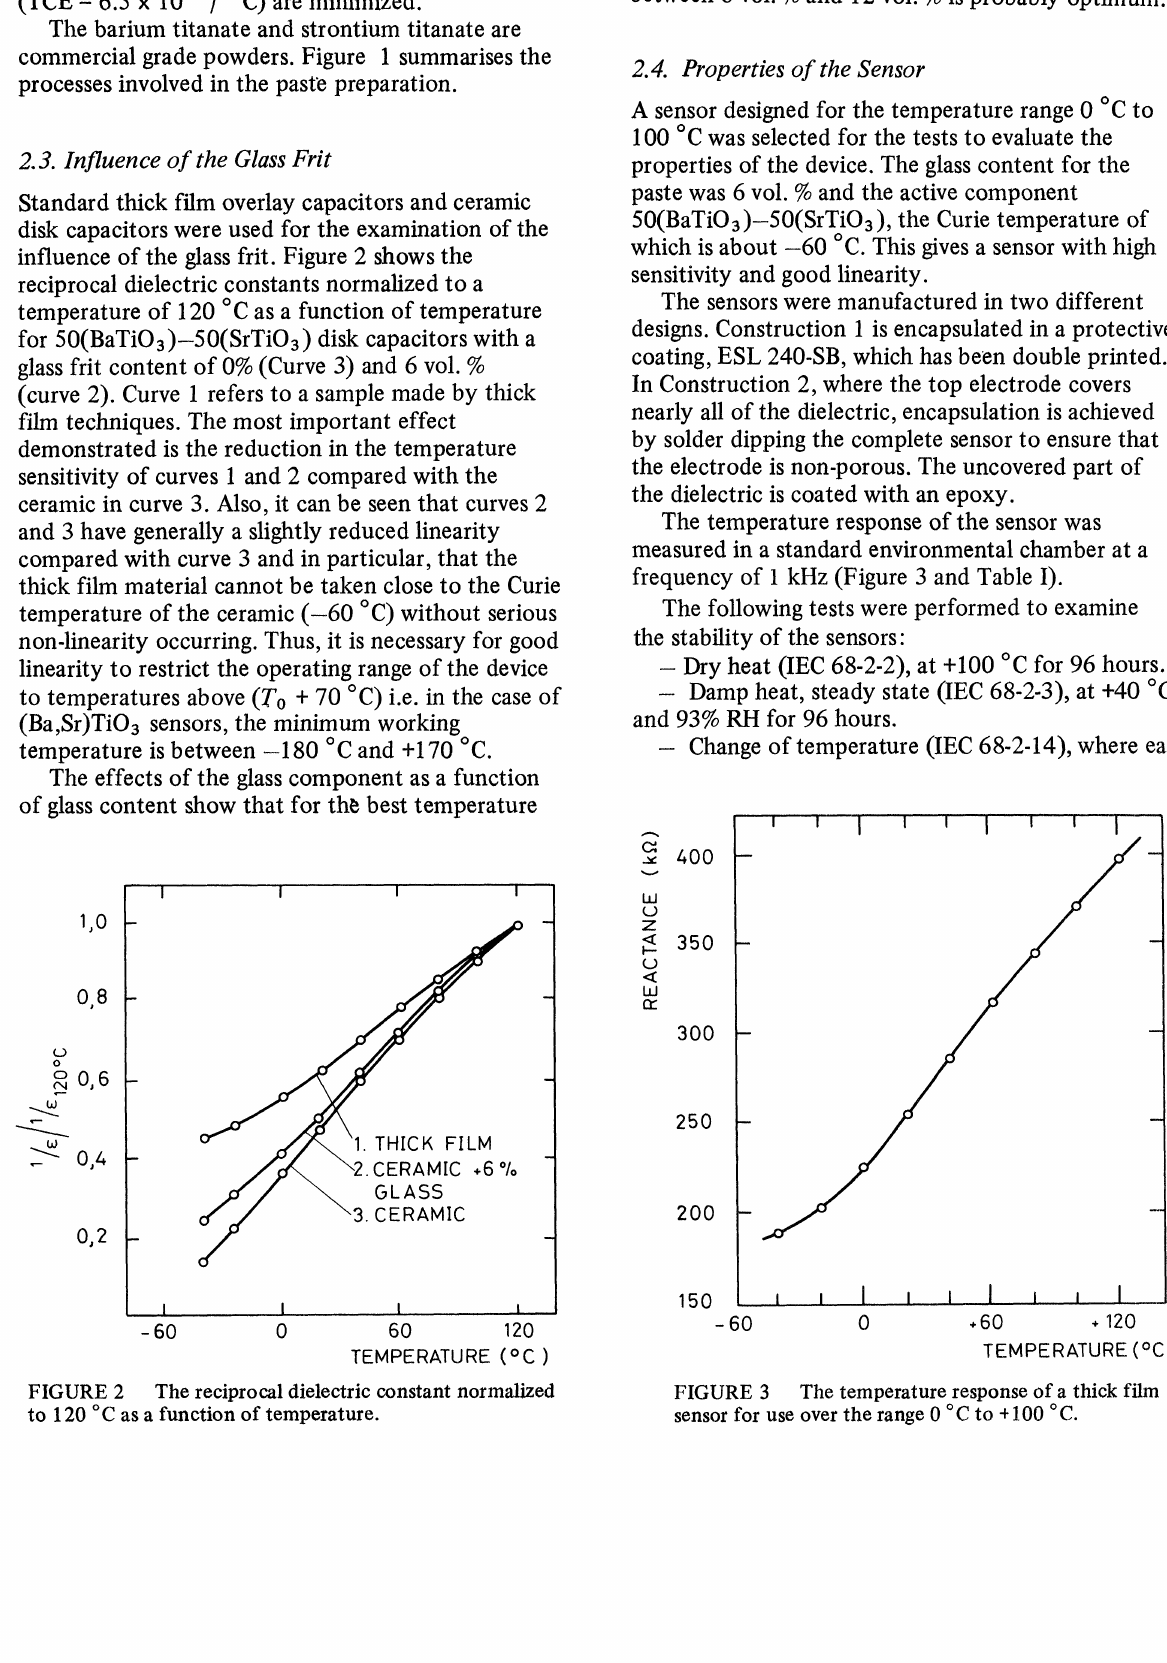
The temperature response of a thick film sensor for use over the range 0 C to / 100